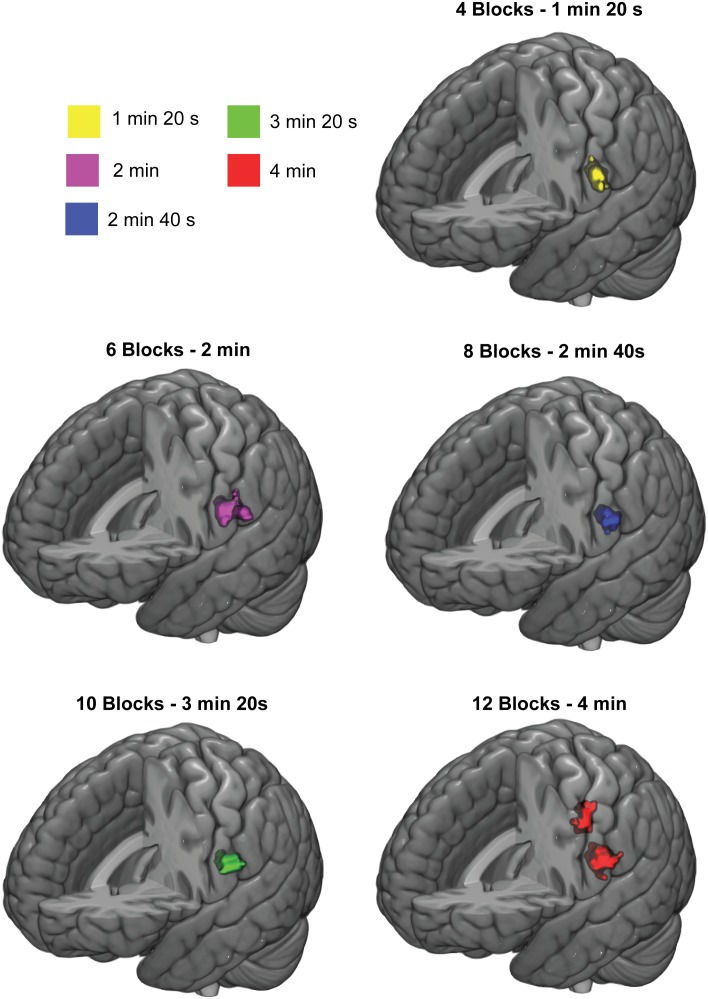
Response clusters for different stimulation durations. Significant group-level activation clusters are colored. Cluster-wise threshold was 0.05 (FDR-corrected) and voxel-wise threshold was 0.001 (uncorrected).